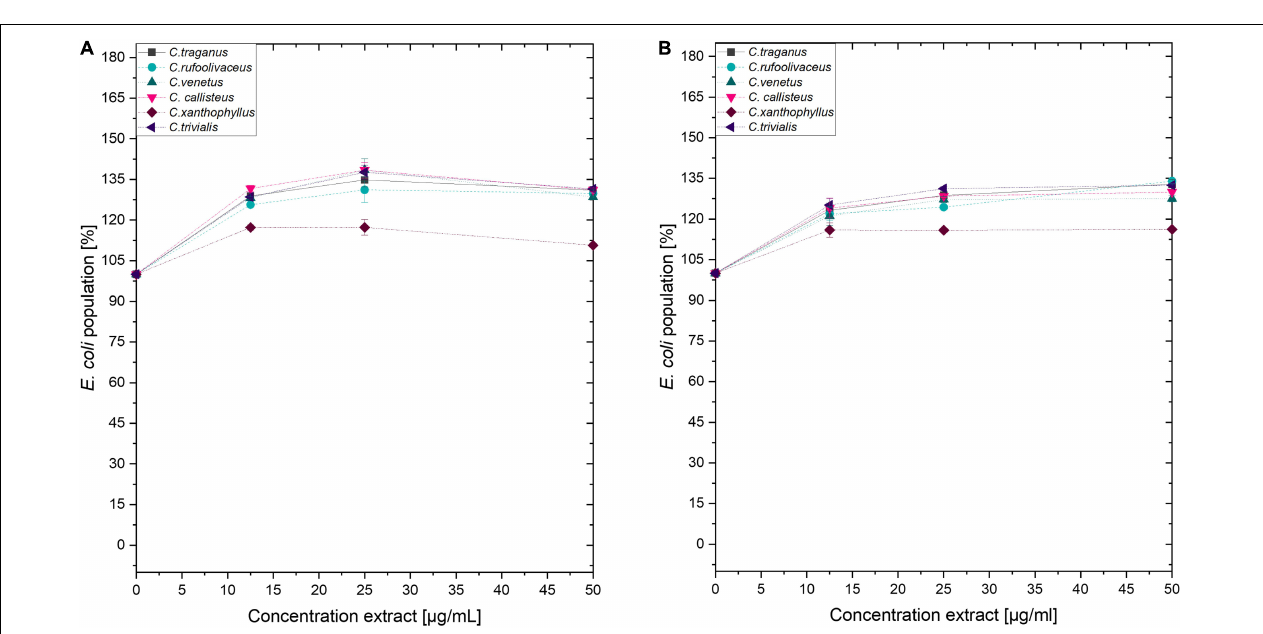
FIGURE 6 | Dose–response curves of C. albicans treated with Cortinarius extracts. On the left side, (A) dark controls are shown. The right graph (B) represents the irradiated experiments ( λ = 478 nm, H = 30 J/cm 2 , PI = 60 min).